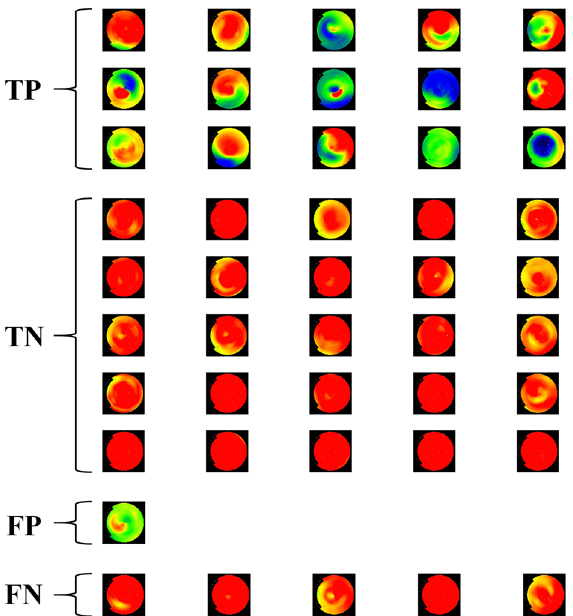
Figure 5. Visualization of polar maps classified as true positive (TP), true negative (TN), false positive (FP) and false negative (FN) from the best classification result with the CNN (accuracy 0.8696, matching the clinical